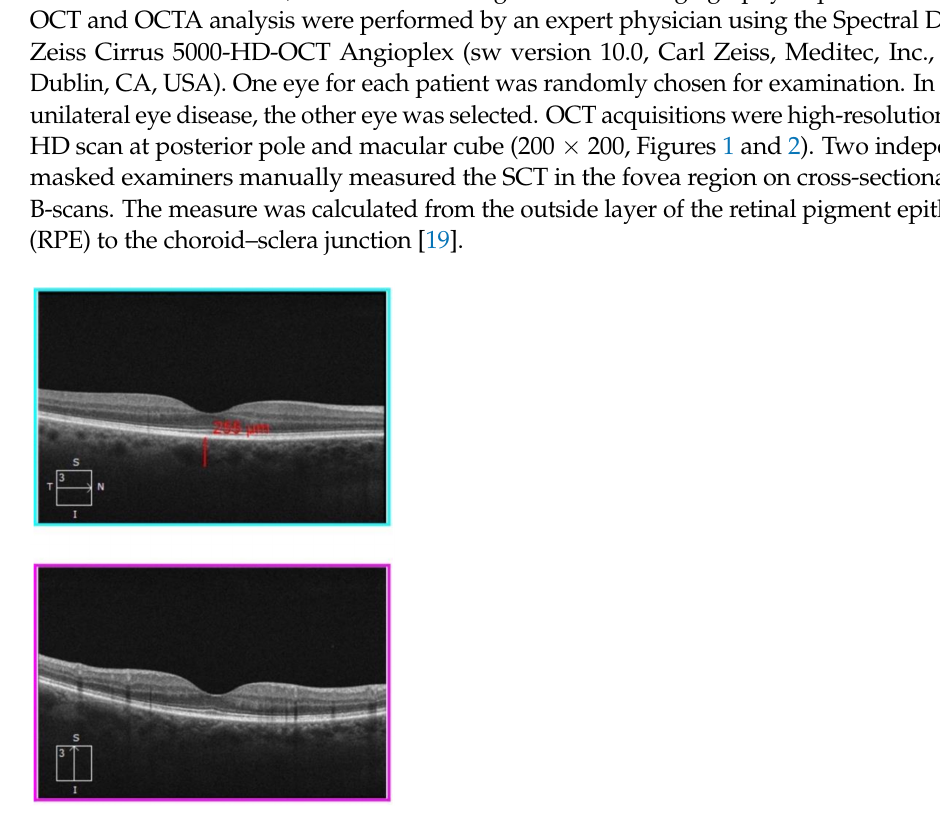
Figure 1. High-resolution 5-line HD scan OCT. Horizontal- and vertical-line OCT B scan. The upper image shows how the SCT was measured by the examiner. SCT = subfoveal choroidal